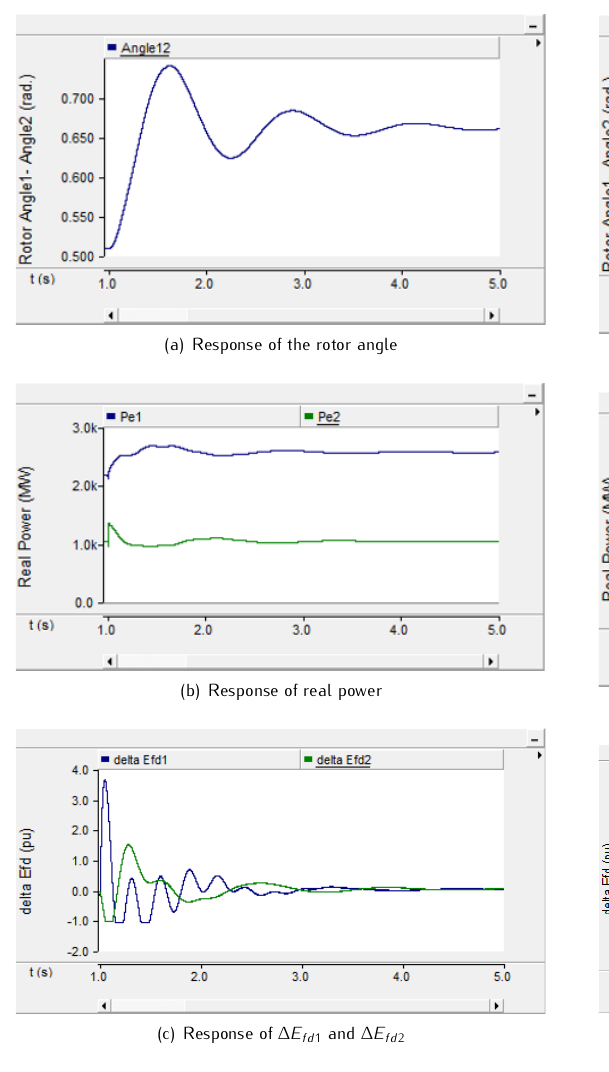
Figure 2. 400 MW increase of power transfer under PSS control. Figure 3. 400 MW increase of power transfer under H-infinity Figure 2 400MW increase of power transfer under PSS control Figure 3 400MW increase of power transfer under H-infinity control